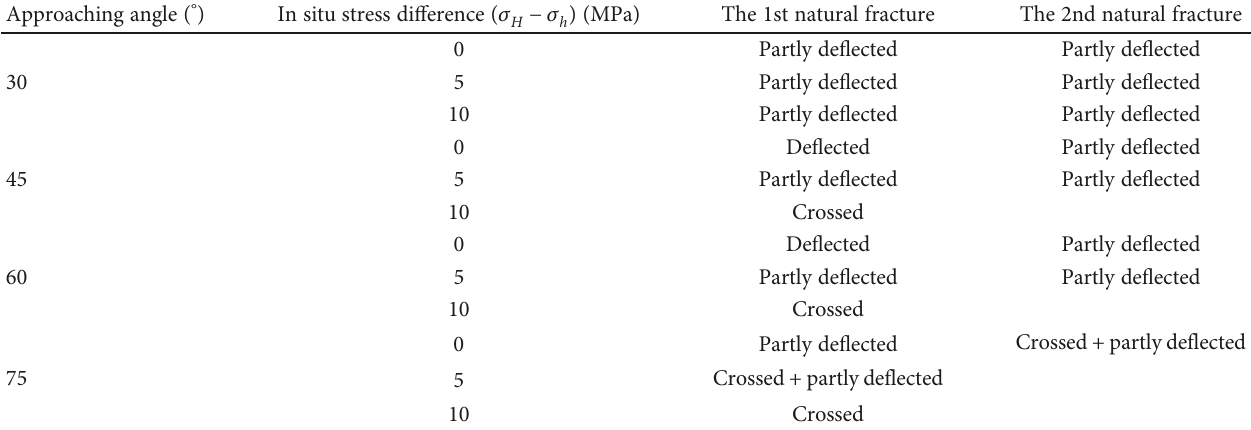
Table 2: The in fl uence of two intersected natural fractures on arti fi cial fracture propagation. Approaching angle ( ° )